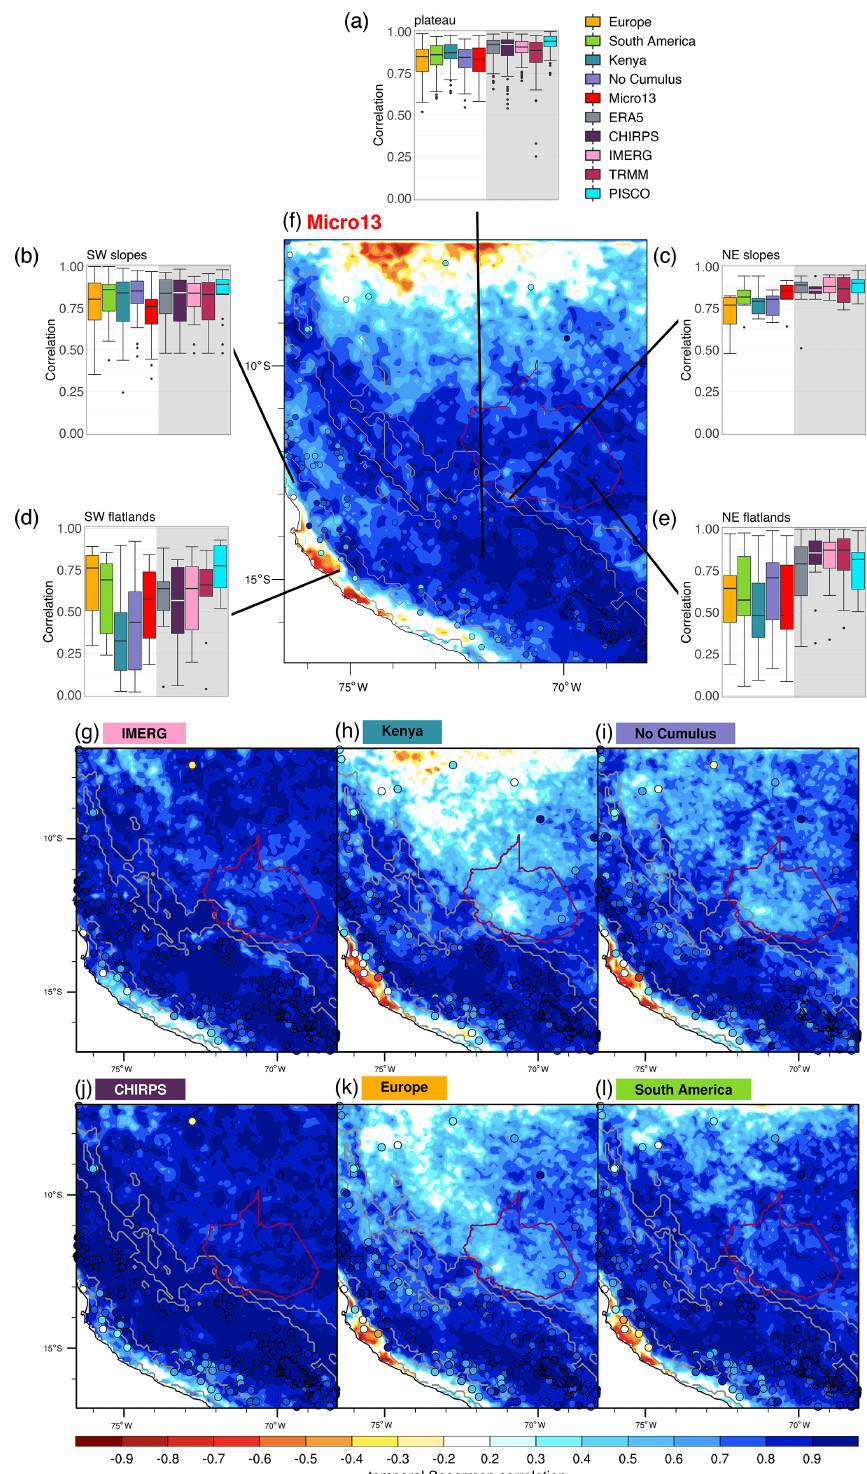
Figure 3. Temporal Spearman correlation against weather station data in the box and whisker plots (a–e) and against PISCO data set (f–l) . The box and whiskers are divided into five groups according to the elevation of each station and location related to the Andean mountain range: (a) the plateau, (b) the SW slopes, (c) the NE slopes, (d) the SW flatlands, and (e) the NE flatlands. The circles on the map indicate the Spearman correlation coefficient with respect to the corresponding weather station. Note that the WRF domain is reduced at the eastern side to match the PISCO data set (refer to Fig. 1 and Sect. 2.2 for more details). The grey shading in panels (a) to (e) denotes the satellite based or reanalysis data, and facilitates the separation from the WRF